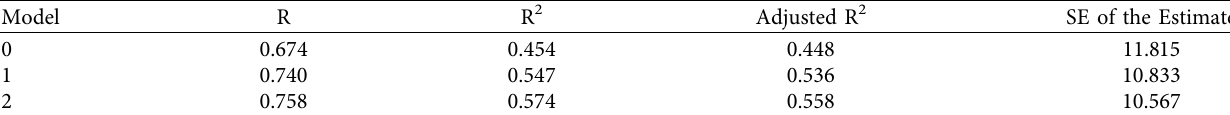
Table 5: Summary results of generalized linear models (received by stepwise including method) of GIT dysfunction, motor disturbances, depression, and anxiety influences on QoL.